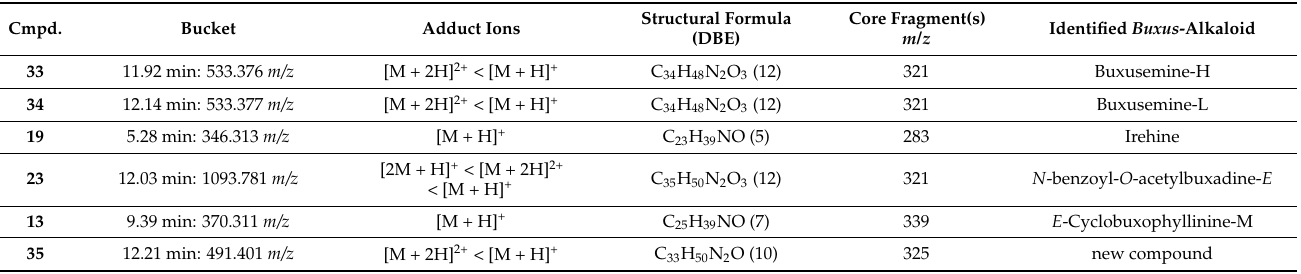
Figure 8. Volcano plot of the comparison of the twig with the leaf extracts. Buckets with a high fold change (|log 2 (fold change)| ≥ 2.32) and a low p -value ≤ 0.05 ( − log 10 ( p ) ≥ 1.3) are shown in yellow. Assignment of compounds that are present in significantly higher concentrations in the leaf extracts compared to the twig extracts. * Structural assignment based only on mass spectral data; stereochemistry tentatively assumed in analogy with known compounds [3]. Table 4. LC/MS-characteristics of compounds displaying a high fold change and a low p -value (compare Figure 8). Cmpd.